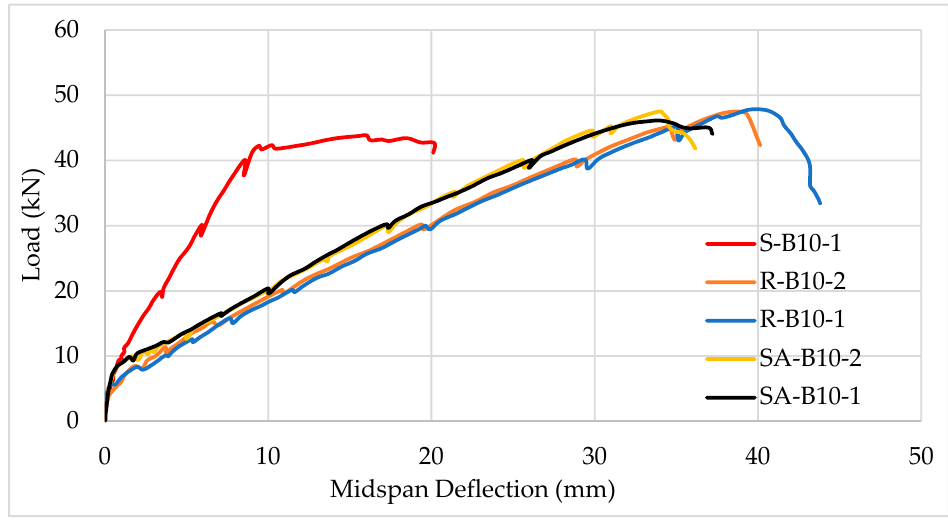
Figure 7. Steel-reinforced beam (S-B10-1) is much stiffer than similar BFRP-reinforced beams.